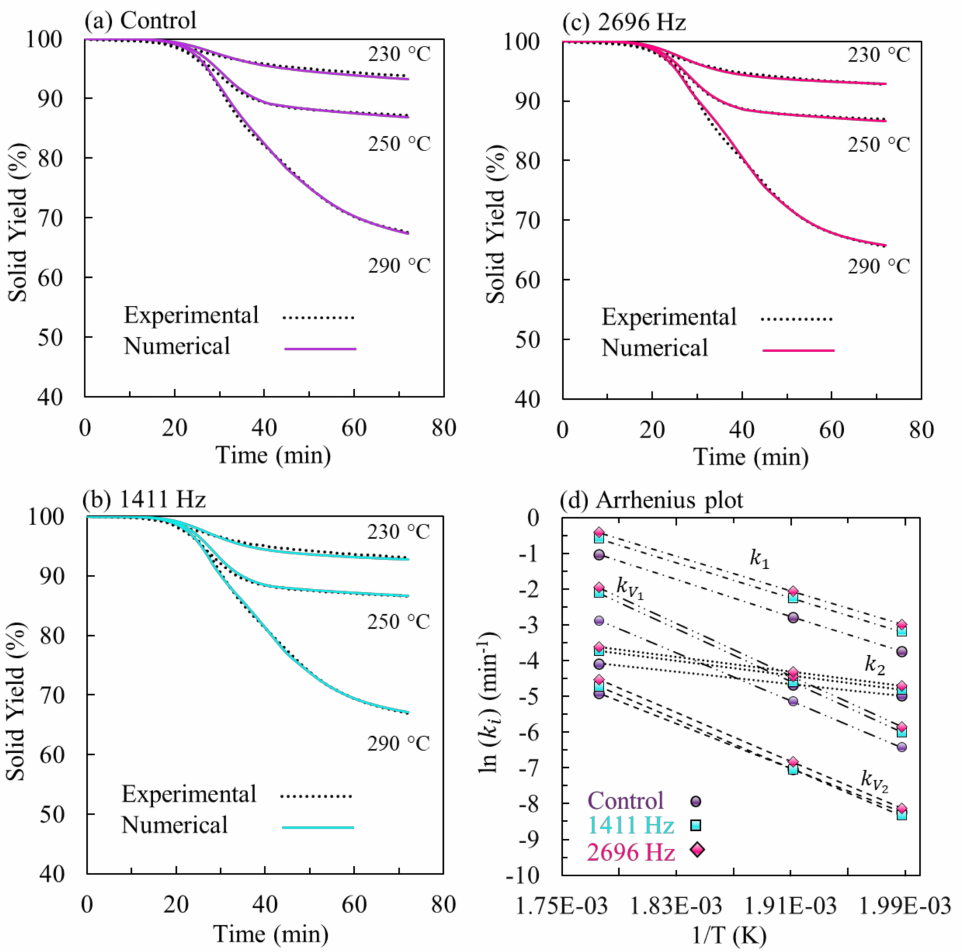
Figure 5. Simulated and experimental curve fitting for ( a ) control and acoustic treatments ( b ) 1411 and ( c ) 2696 Hz performed at 230, 250, and 290 ◦ C temperature treatments. ( d ) Arrhenius plot of reaction rates for control, 1411, and 2696 Hz